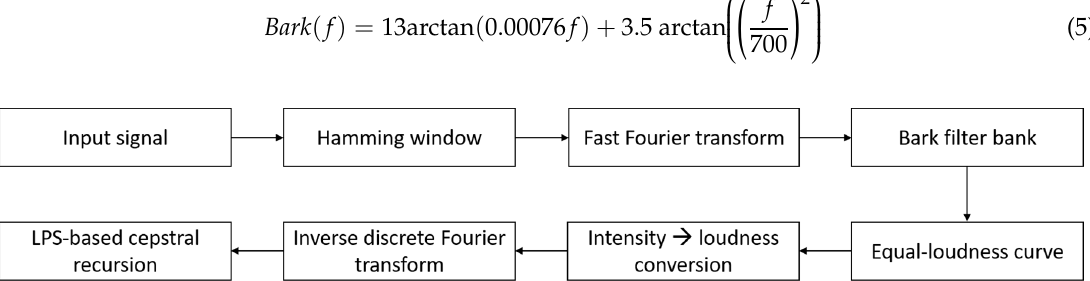
Figure 13. The general Perceptual Linear Predictive (PLP) computation steps.